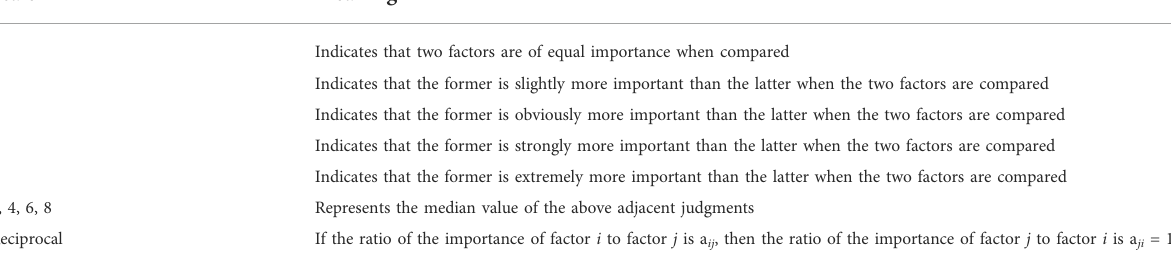
TABLE 3 Scales of Judgment matrix and their meanings.